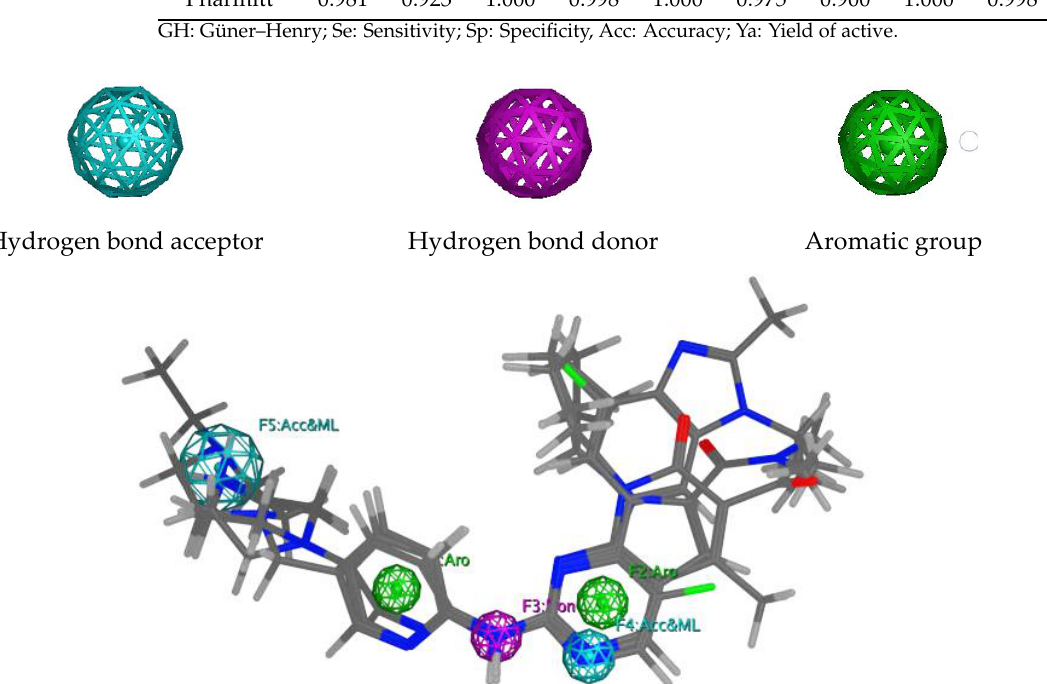
Figure 2. An overlay of the aligned structure of palbociclib, ribociclib, and abemaciclib on pharmacophore model 77.